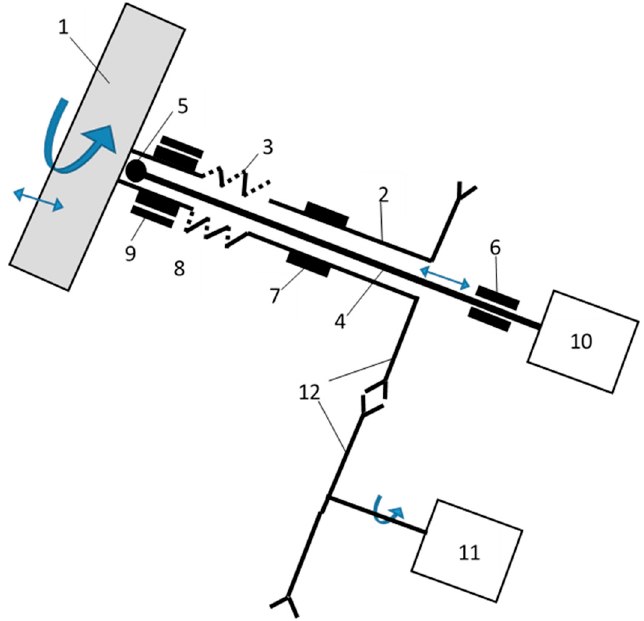
Figure 7. Vibrating disc granulator.